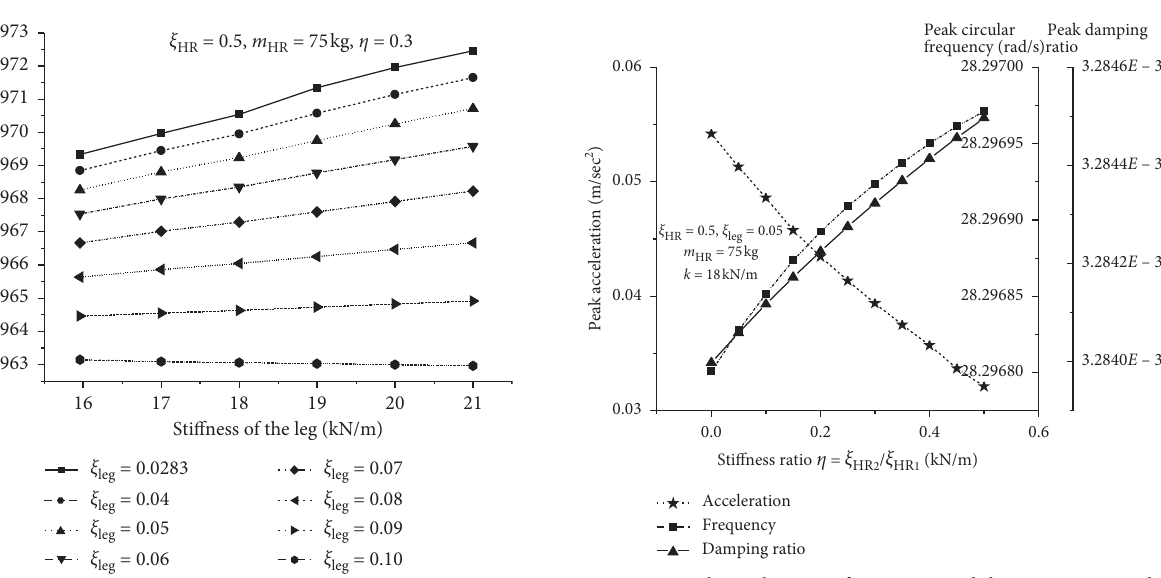
� 0 . 5, η � 0 . 3, and HR